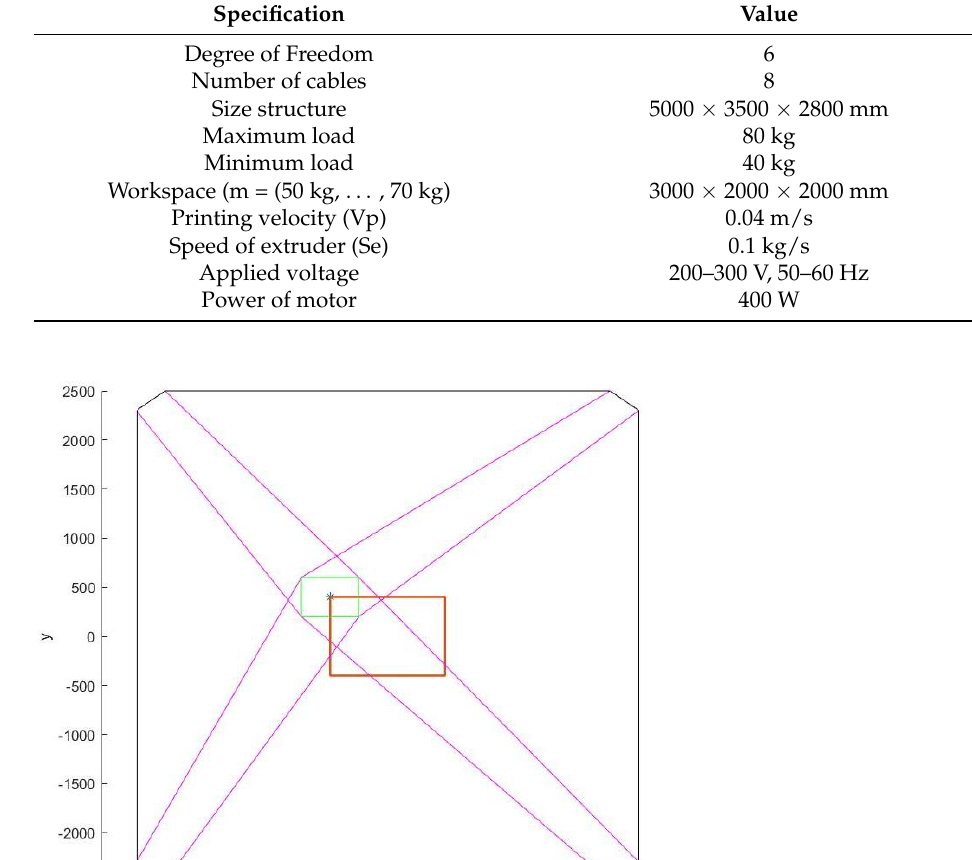
Table 1. Specifications of the 3D concrete printing cable robot.